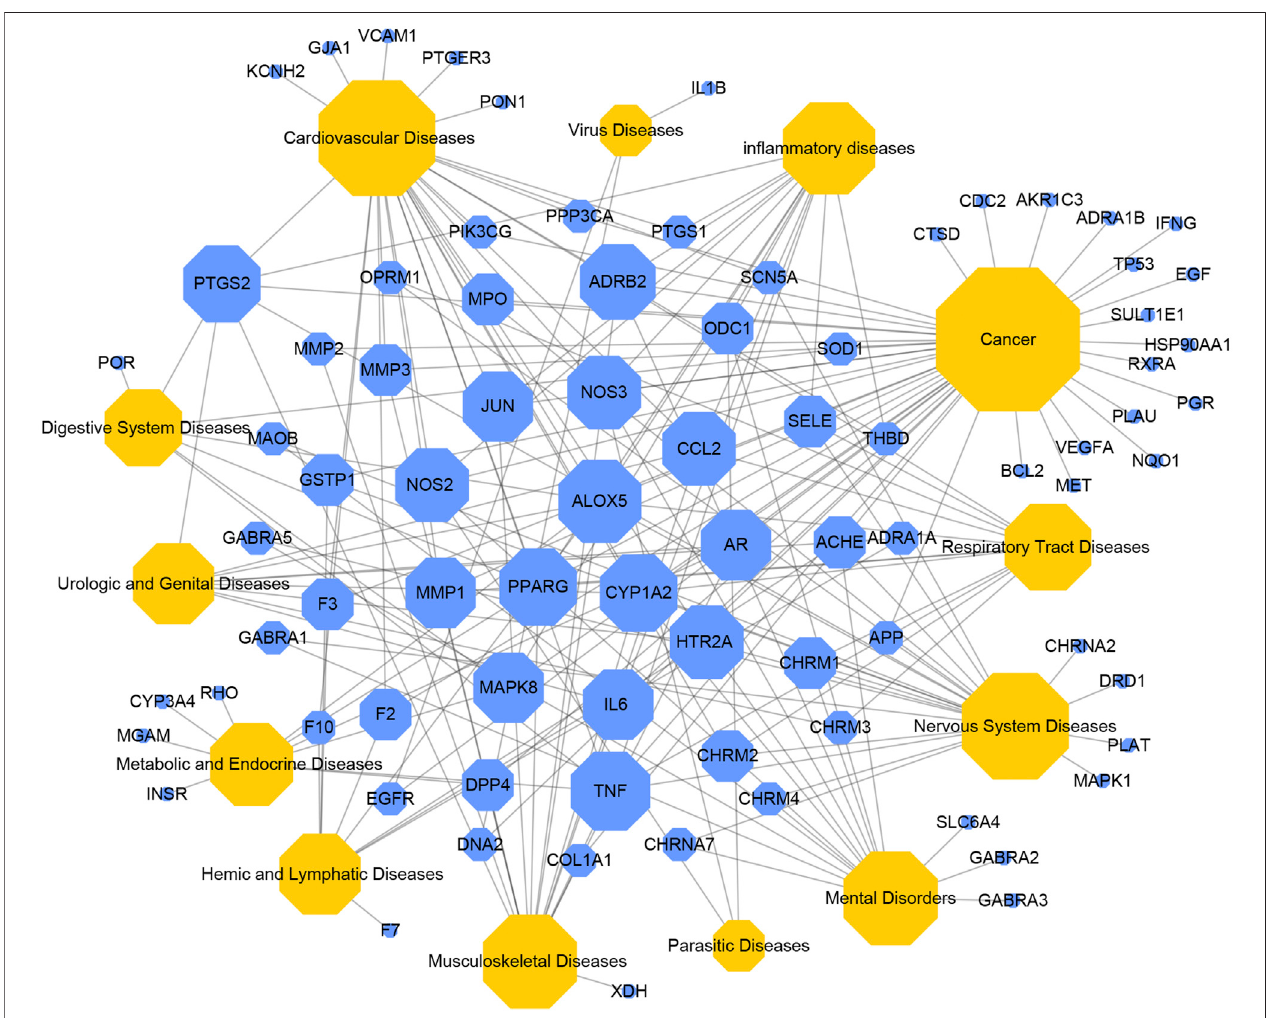
FIGURE 3 | Target – disease network. Blue nodes represent targets, and yellow nodes represent diseases. The node size is proportional to its